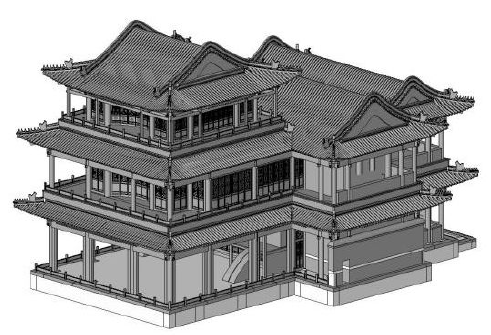
Figure 11. BIM model of The Great Theater